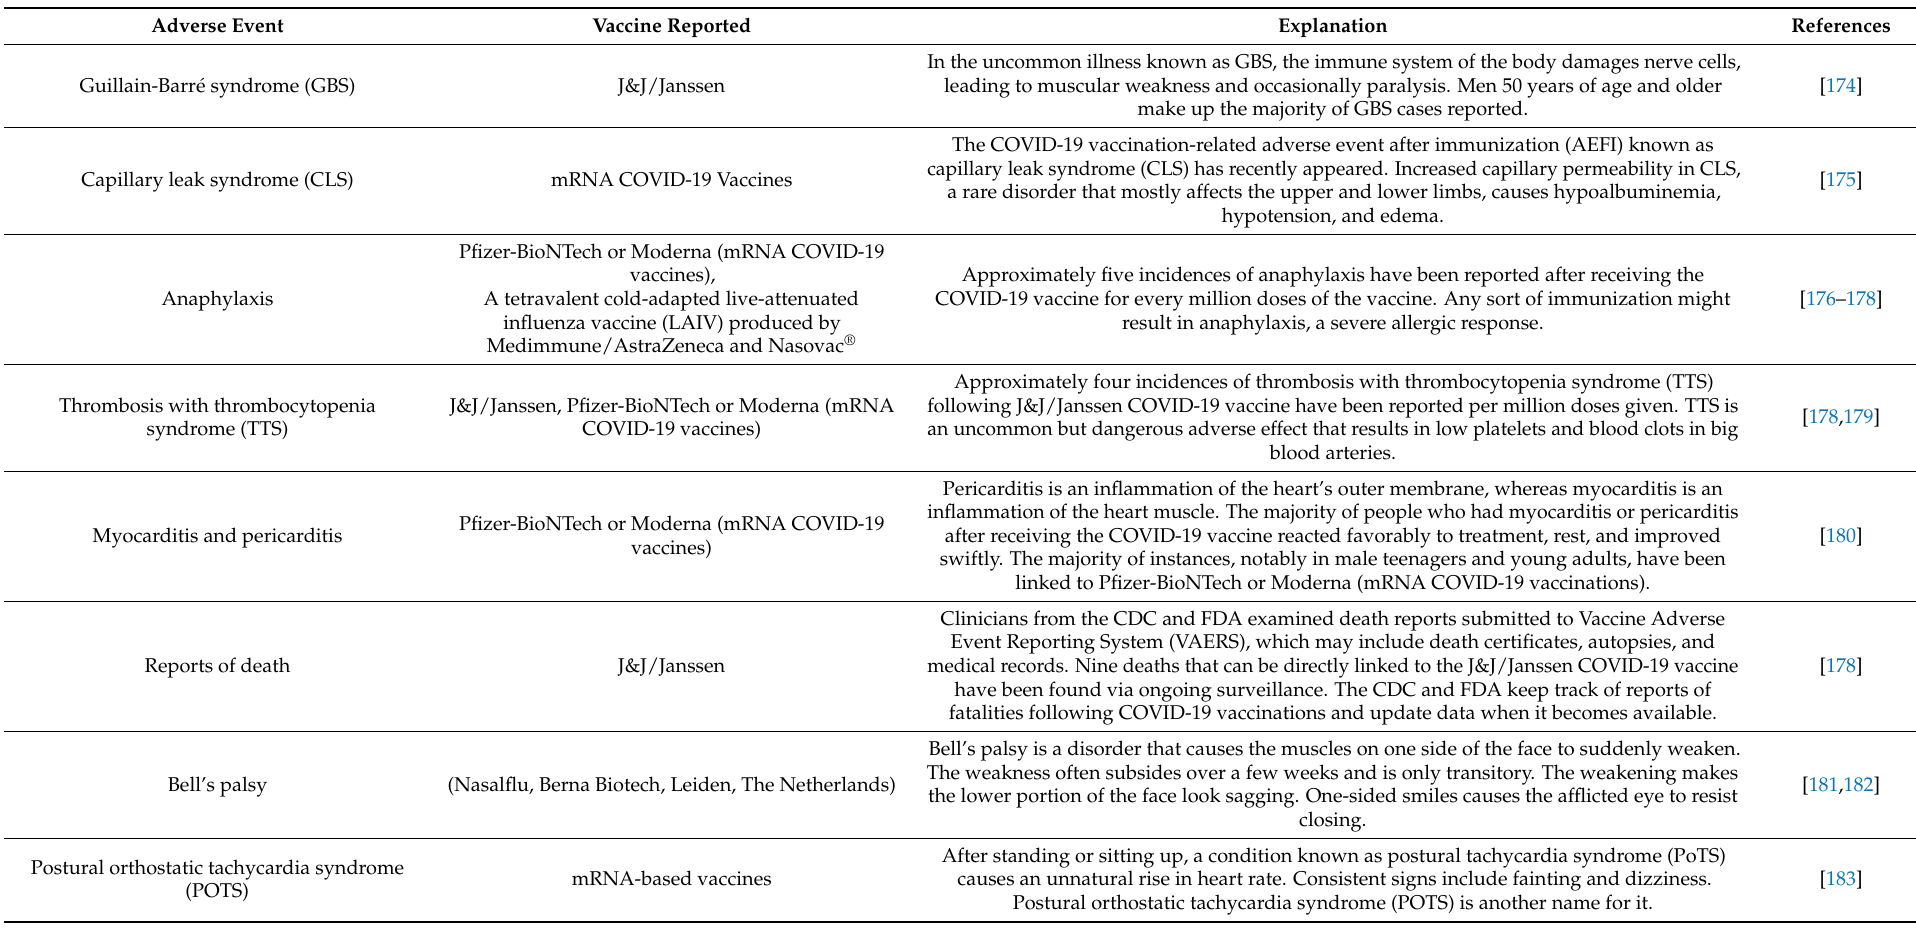
Table 3. Safety Concerns of Intramuscular vaccines and Intranasal